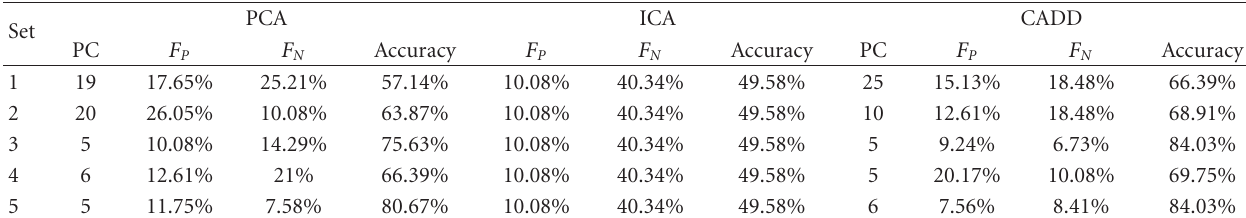
Table 2: F P and F N ; and total PCA, ICA, and PCA-ICA algorithms accuracy.